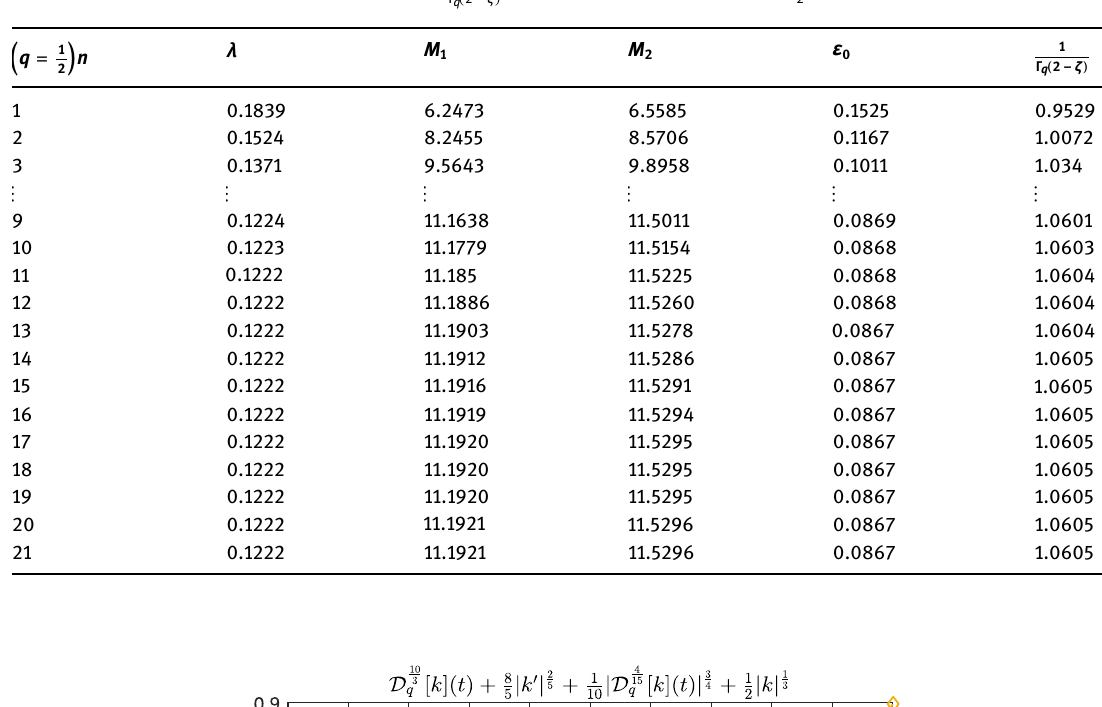
Table 7: Some numerical results of λ , M 1 , M 2 , ε 0 ,